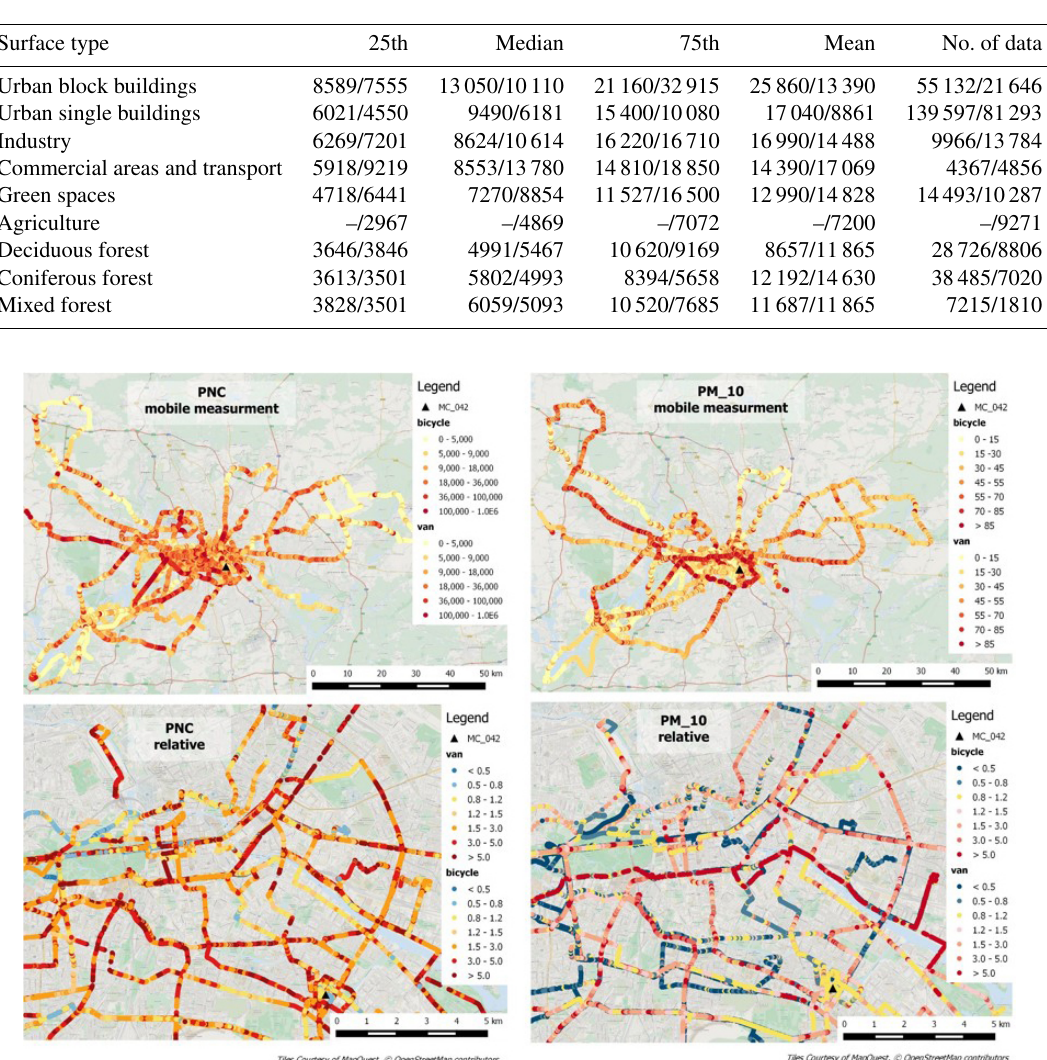
Figure 5. Heterogeneity of particle number (left) and mass (PM 10 , right) concentrations in and around Berlin detected by bicycle and van sensors. The upper line displays the total area and the bottom line provides the relative values for number and PM 10